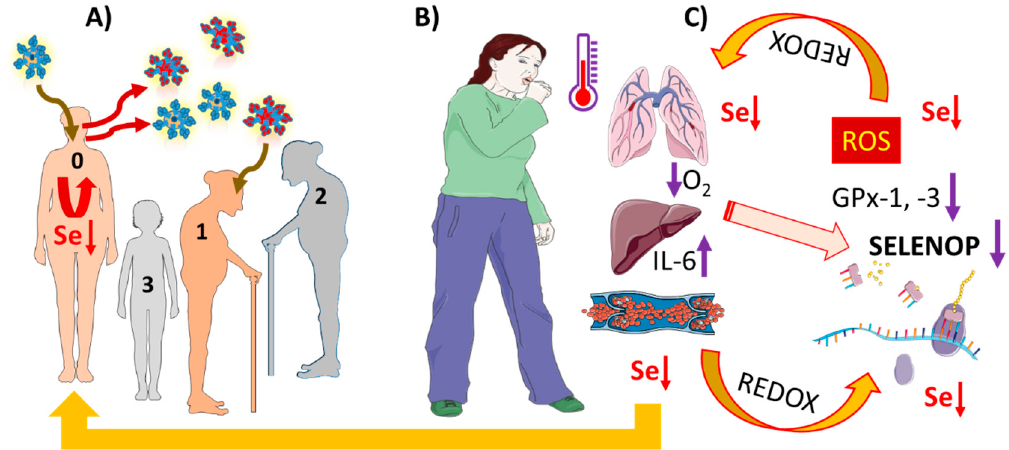
Figure 5. Pathophysiological mechanisms potentially underlying low Se status in severe COVID-19. Infections by SARS-CoV-2 occur largely independent from baseline Se status. ( A ) Some individuals with a poor immune system and low baseline Se status (0) may spread the virus (blue) efficiently and allow viral replication and rapid evolution of particular pathogenic viral species (red) due to low expression of protective selenoenzymes. Subjects with better Se status (1–3) may be less prone to severe disease course. ( B ) COVID-19 is characterized by inflammation, hypoxia, and high cytokine concentrations (e.g., IL-6). The combination of hypoxia and IL-6 suppresses selenoprotein expression.